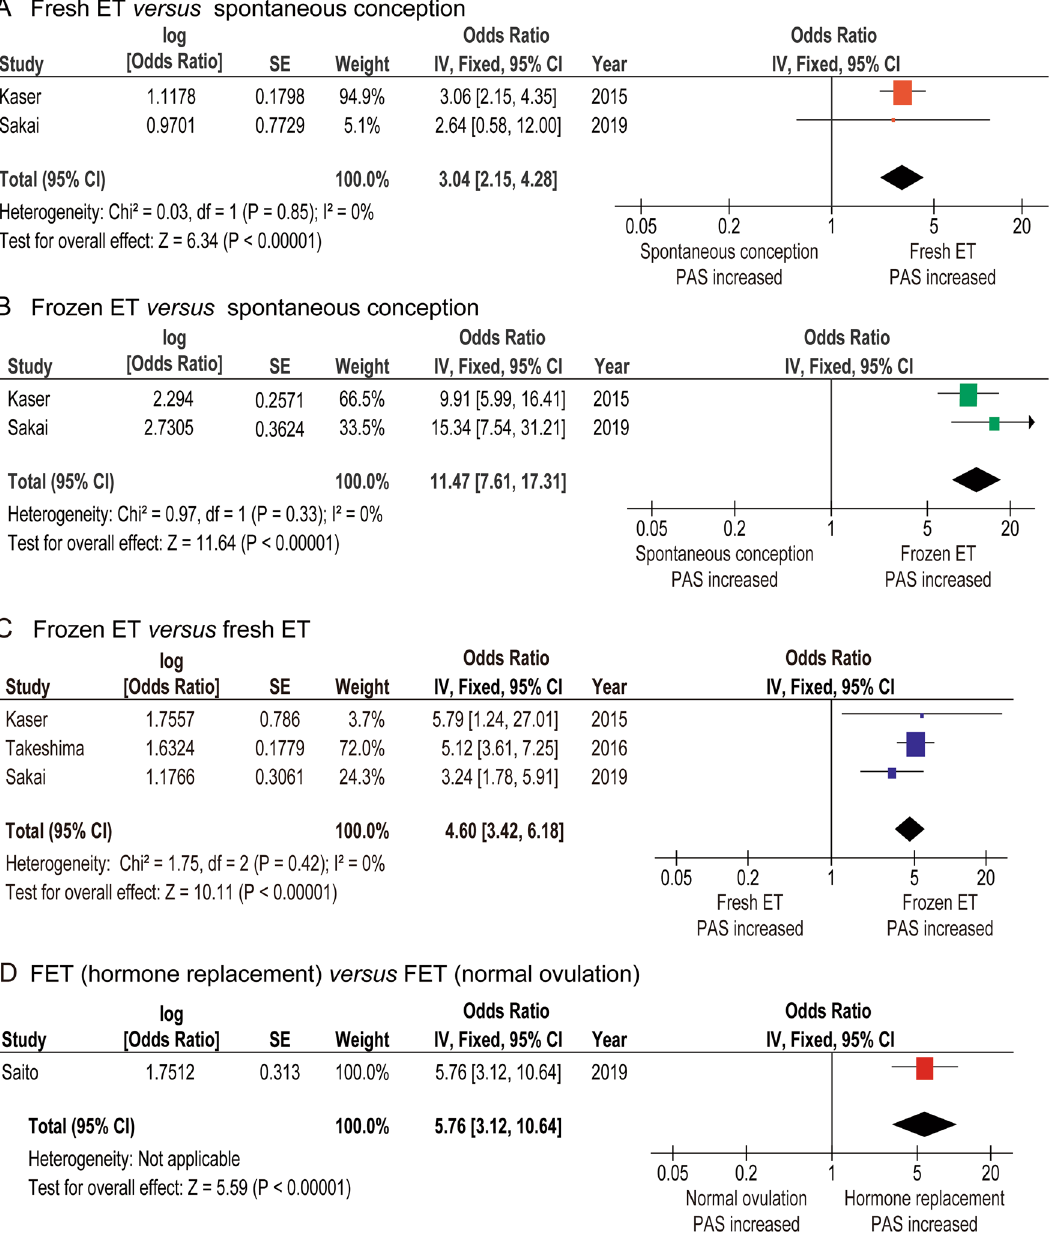
Comparison with existing literature. Several studies have reported that IVF-ET is associated with an increased risk of PAS. The first study that showed the relationship between IVF-ET and PAS was published in 2011 12 , but it did not determine the risk of PAS according to the type of IVF-ET 12 . Subsequently, Kaser et al . examined the risk of PAS in different groups (spontaneous conception [ n = 53,376], fresh ET [ n = 1,351], and frozen ET [ n = 220]) 11 . The authors found that women with an endometrial thickness of < 9 mm before ET had a greater risk of PAS than women with an endometrial thickness of ≥ 9 mm; thus, a thin endometrium may lead to PAS. In their analysis, the median endometrial thickness before ET was 8.4 mm in the frozen ET cycle and